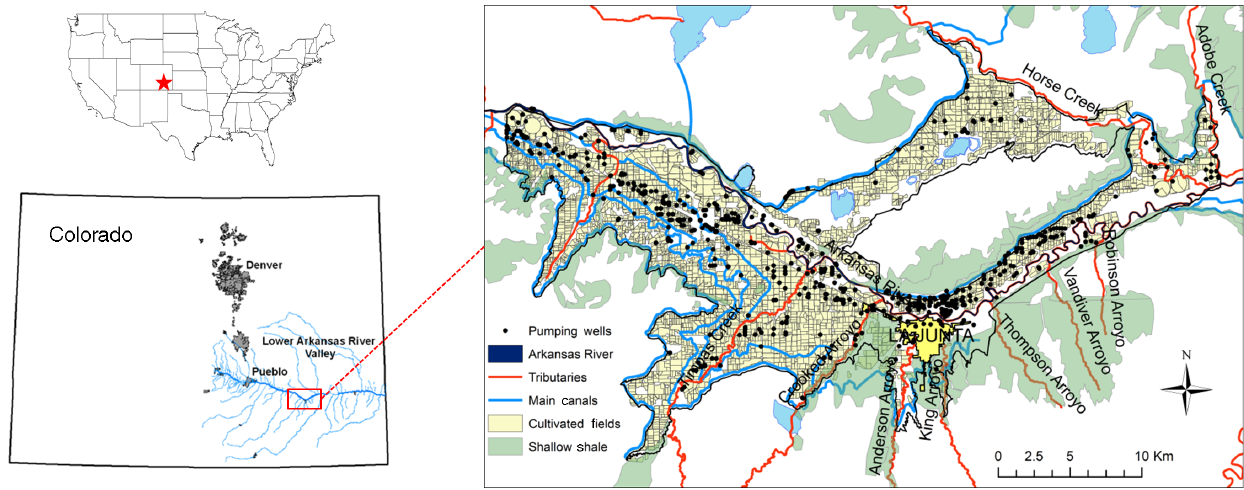
Figure 1. Location and hydrologic features of the study region in the lower Arkansas River valley in southeastern Colorado, showing the Arkansas River and tributaries (red), cultivated fields (yellow), irrigation canals (light blue), groundwater pumping wells (black dots), and the extent of near-surface shale (within 2m of the ground surface)